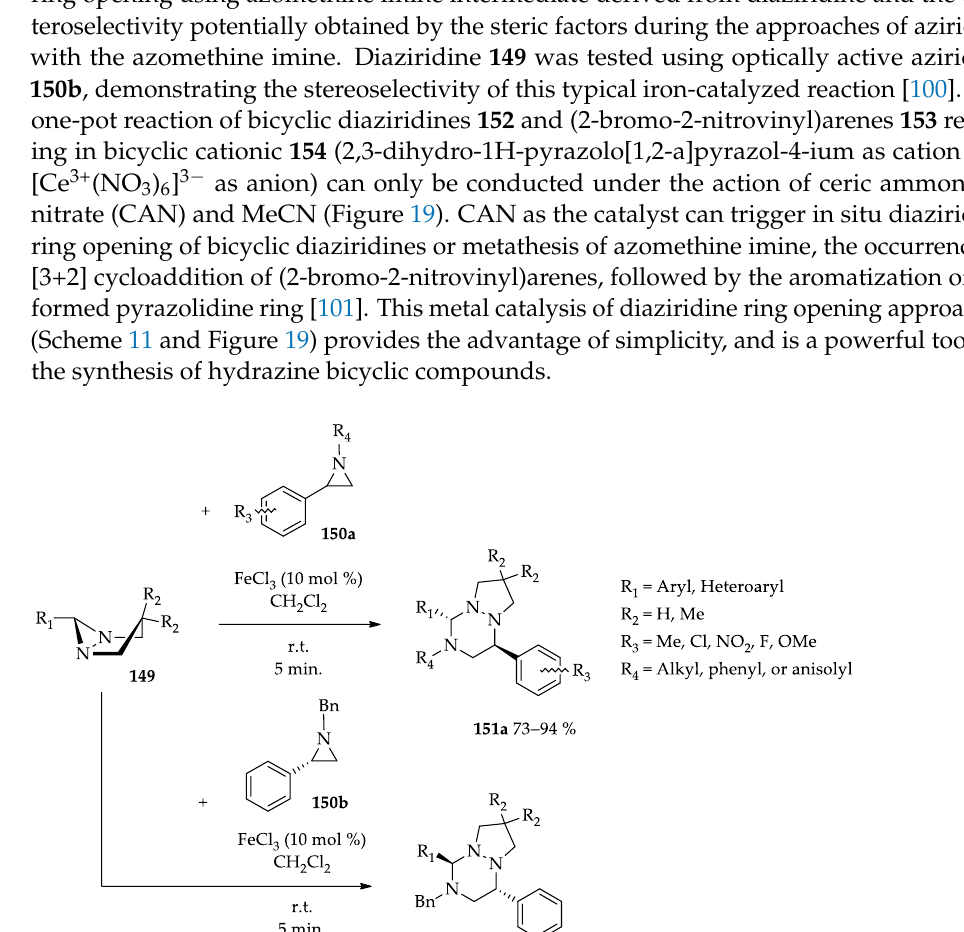
Figure 19. CAN-mediated synthesis of bicyclic cationic 154 with 2,3-dihydro-1H-pyrazolo[1,2-a]py- razol-4-ium core. 3.3.4. Diaziridine Reaction with Donor–Acceptor Cyclopropanes/Cyclopropenes The first [3+3]-annulation of two different three-membered rings of bicyclic diaziri- dines 154a−n and donor–acceptor cyclopropanes 155 was reported in 2018 [102]. The re- action afforded perhydropyridazine derivatives 156 in high yields and diastereoselectiv- ity under mild Lewis acid catalysis of Ni(ClO 4 ) 2 ·6H 2 O (Figure 20). Under the same condi- tions, the difference of alkyl substituent(s) at the C(6) atom of bicyclic diaziridine 154k,o−u can prevent (3+3)-annulation. The spiro-[cyclohexane-1,6′-(1,5-diazabicyclo[3.1.0]hex- ane)] and other bulky substituents at the C(3) atom of the diaziridine ring of 1,5-diazabi- cyclo[3.1.0]hexanes ( 154k,o−u,v ) did not produce the corresponding hexahydro- pyridazine 156 and afford 1-alkylated 2,3-dihydropyrazoles 157 or 158 in the reaction with donor–acceptor cyclopropanes 155 [103]. The reaction possibly proceeds via the alkylation of a diaziridine derivative with a Lewis acid-activated cyclopropane, followed by hydra-